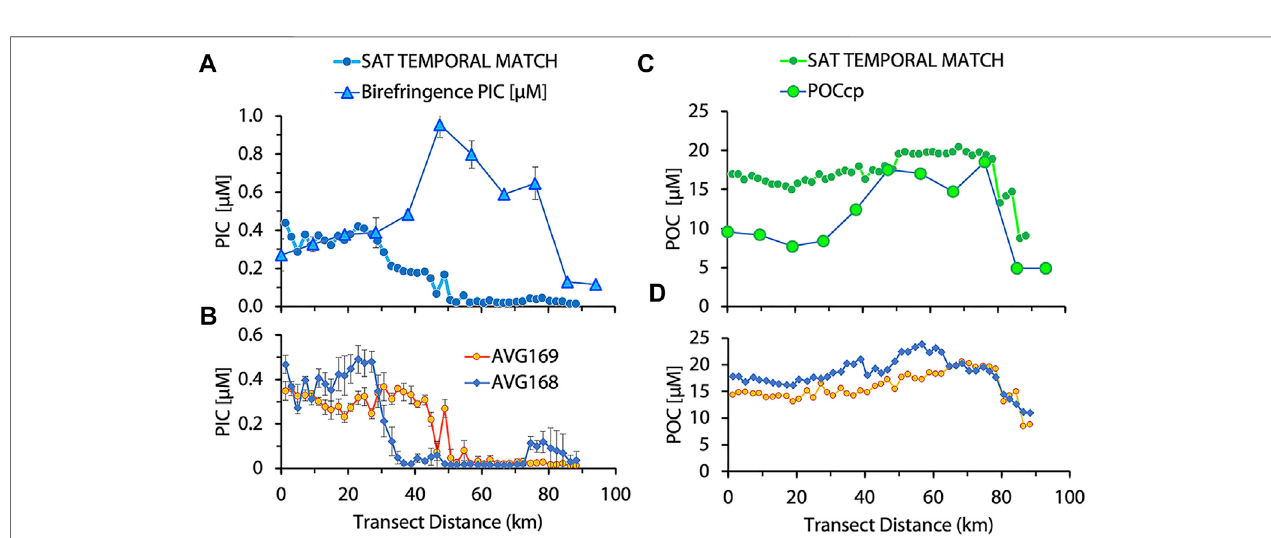
FIGURE 13 |(A) Comparison of surface layer PIC concentrations derived from PIC011 alongTransect T2 with time interpolation of PIC retrieved from VIIRS SNPP satellite data from days 168 and 169. (B) PIC retrieved from VIIRS SNPP satellite data from days 168 and 169. (C,D) similar comparisons for POC derived from transmissometer beam attenuation coef fi cient and satellite retrievals. In the case of PIC, the satellite retrieval of PIC agreed well along the fi rst 30 km of the transect and then strongly diverged to near zero values while sensor PIC reached concentrations of (cid:5) 1 µM. Retrievals of POC from CTD casts and satellite data were far more in